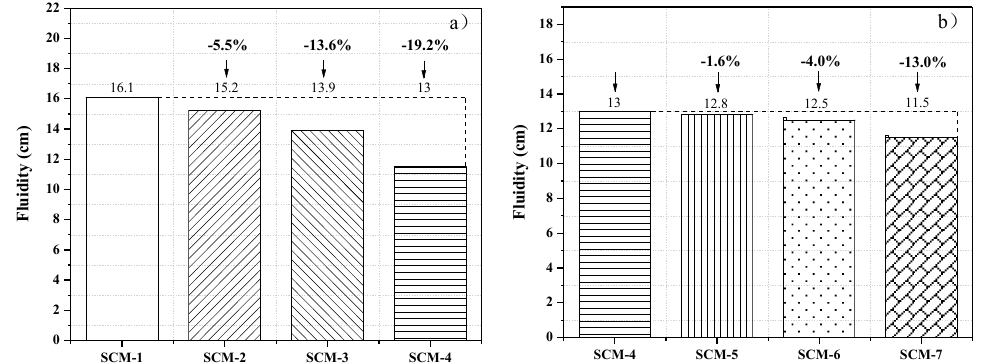
Figure 3. Slump flow diameters of seawater coral mortar (SCM) samples at varying ( a ) coral sand replacement rates and ( b ) PVA fiber contents.